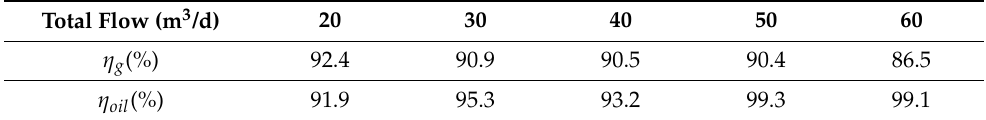
Table 5 . Gas – liquid separation efficiency at oil – gas – water multiphase flow .